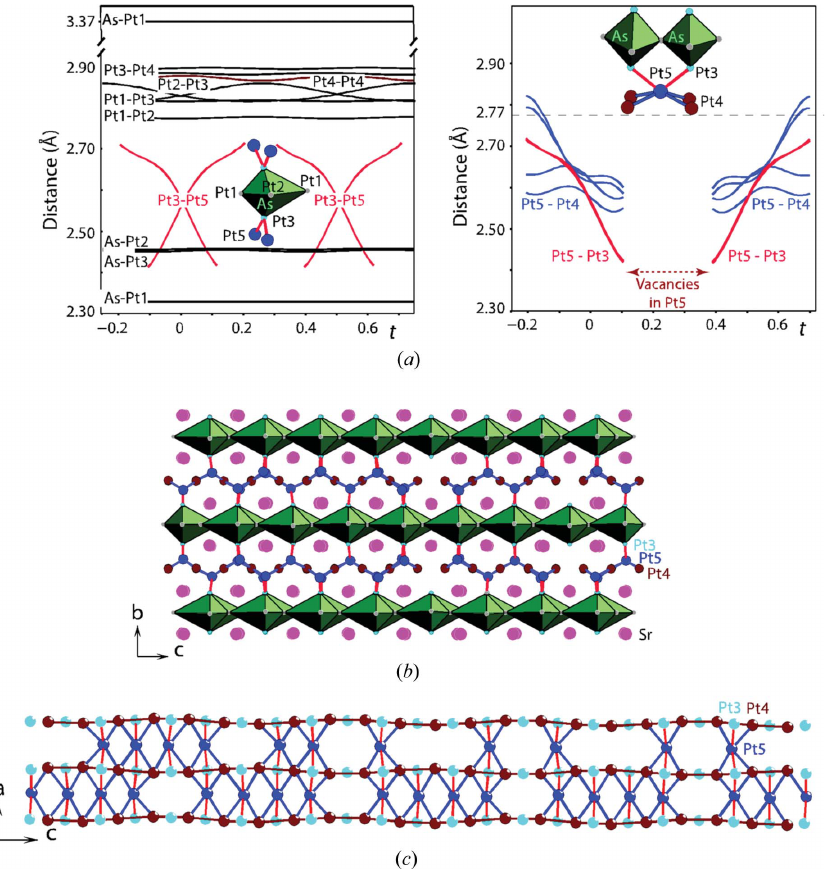
Figure 4 Interatomic distances in the Sr 2 Pt 7.285 As IM structure. ( a ) The t plot of the As–Pt and Pt–Pt distances. ( b ) A portion of the incommensurate structure with an indication of the most variable Pt5–Pt3 (red) and Pt5–Pt4 (blue) distances. ( c ) Variations of the Pt5–Pt3 and Pt5–Pt4 distances are determined by a wave of the Pt4 displacement along the a axis. The distances are indicated by identical colours in ( a ), ( b ) and ( c